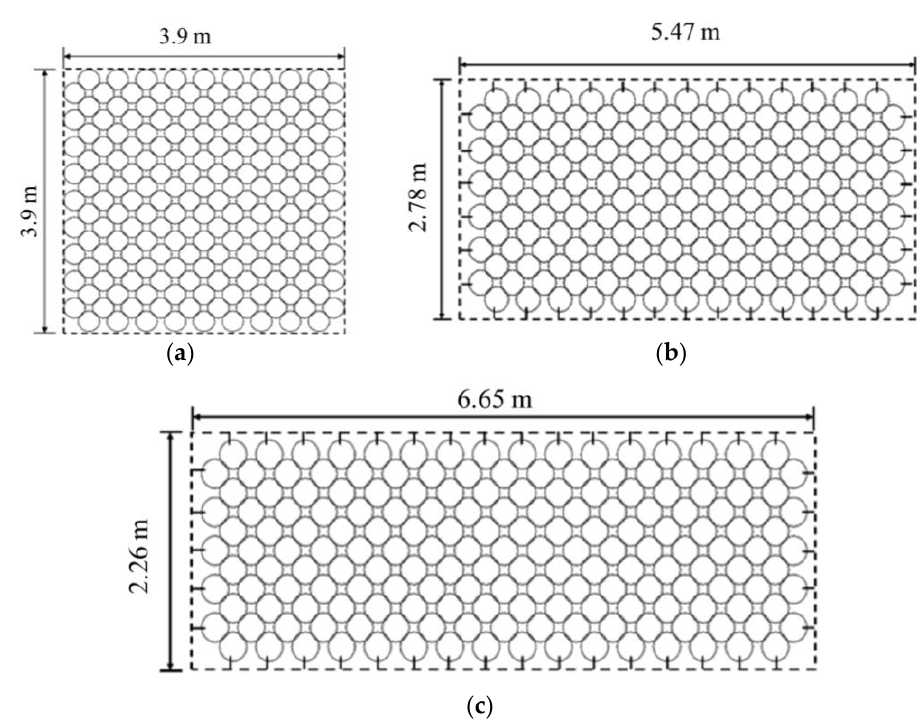
Figure 17. Equivalent coefficients at different ring diameters.